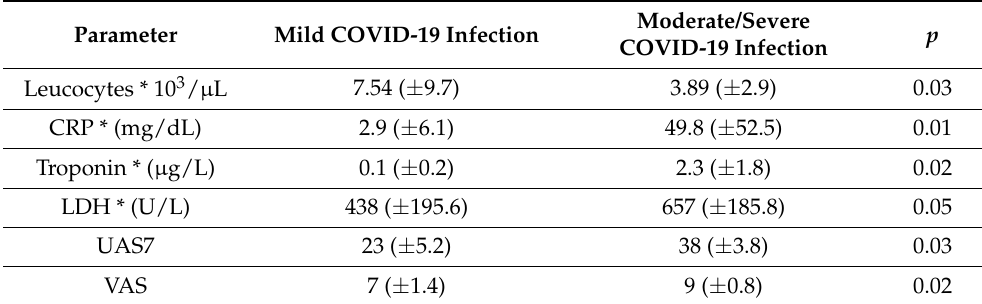
Table 4. Inflammation markers in CSU patient during COVID-19 mild or moderate-severe infection.